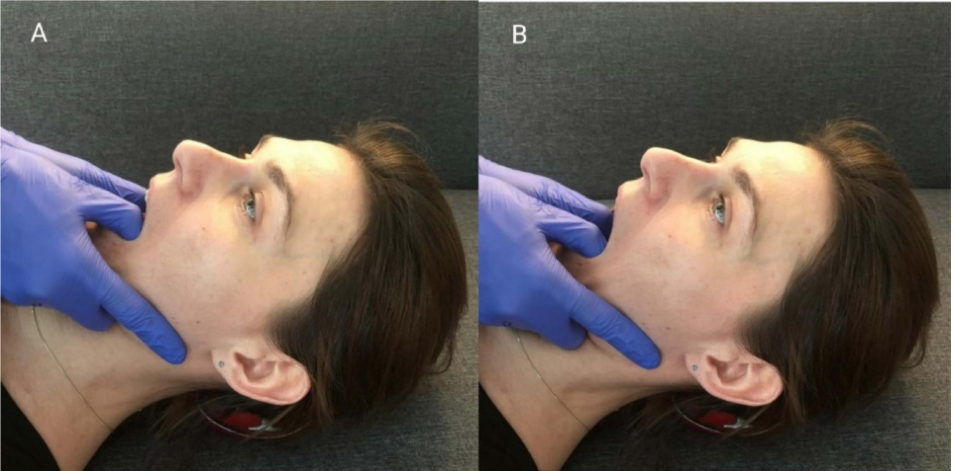
Figure 3. PIR procedure for mandibular adductors: ( A ) Starting position; ( B ) passive abduction of the